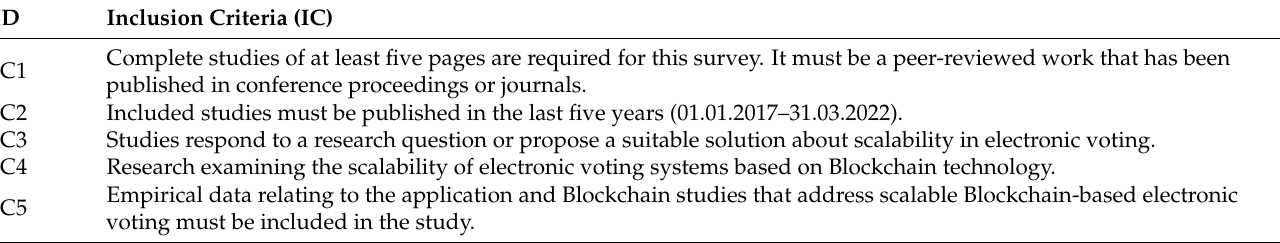
Table 4. Inclusion criteria for systematic literature